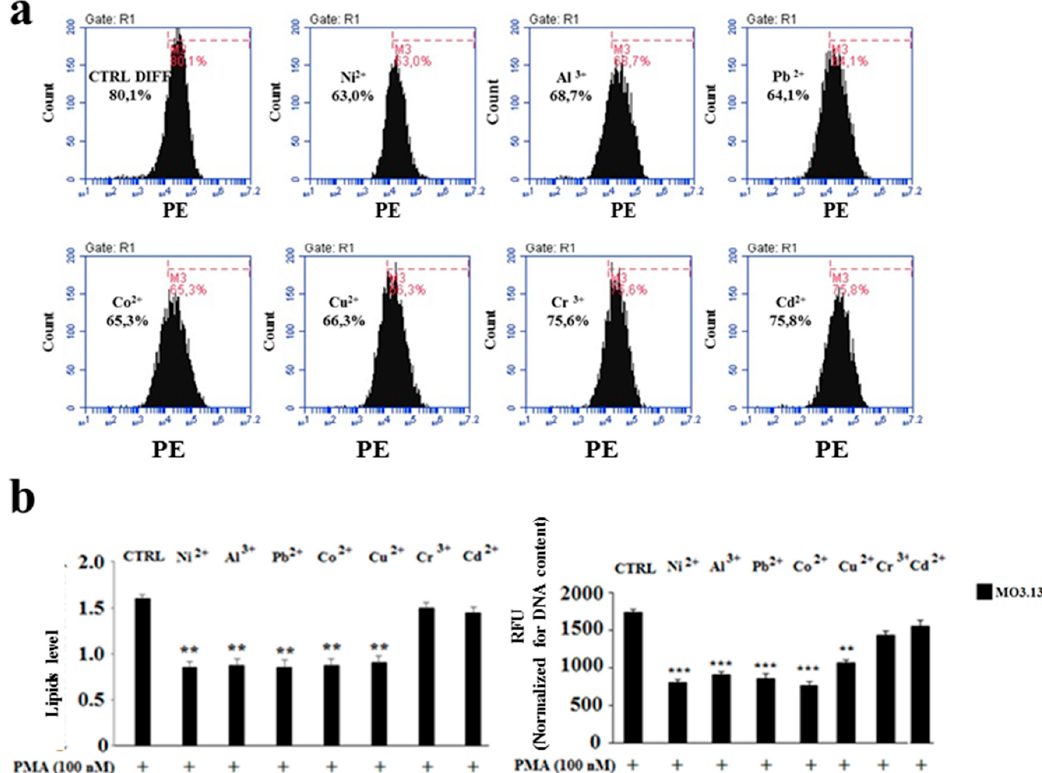
Figure 5. Oligodendrocyte lipid quantification through flow cytometric and spectrophotometric analysis. Di ff erentiated human oligodendrocytes and human neurons were grown separately and treated with heavy metals for 24 h. At the end of the treatment, the cells were picked up and incubated at 37 ◦ C with Nile Red and analysed with the FACS Accury flow cytometer. For the purposes of the spectrometric assessment of lipids, the cells, after the treatment with heavy metals and incubation with Nile Red colouring agent, were picked up and lipids were extracted through the Bligh & Dyer method. Then, the lipid content relating to each sample was subjected to spectrometric reading. The values thus obtained were normalised for the cellular DNA content. Panel ( a ) denotes representative plots relating to the flow cytometric reading of oligodendrocytes with the corresponding marker which shows the shift of the peaks to the right or left. Panel ( b ) on the left indicates the quantification of the flow cytometric analysis of oligodendrocytes; on the right, the values, which were obtained through the spectrometric analysis, are reported. Values of three independent experiments are expressed as mean ± standard deviation (sd). ** denotes p < 0.01 vs. di ff erentiated control; *** denotes p < 0.001 vs. di ff erentiated control. Analysis of Variance (ANOVA) followed by the Tukey-Kramer comparisons test.